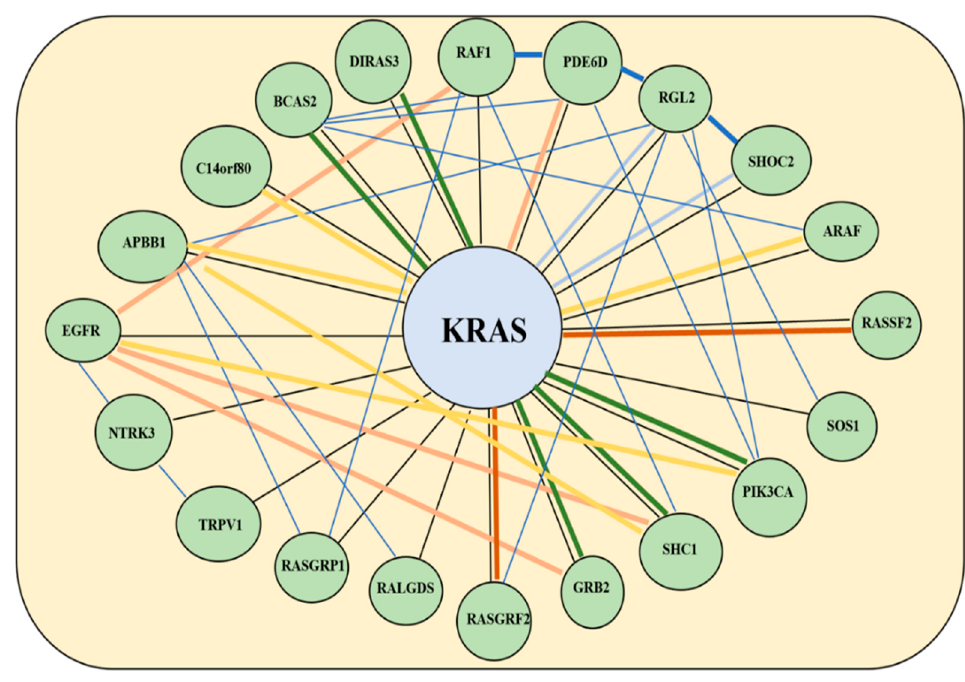
Figure 4. Gene co-expression network for KRAS as depicted using data from the Gene Expression Omnibus on the GeneMania platform. The differing thickness in lines relates to the strength of co- expression (thicker lines show stronger co-expression). Yellow lines denote physical interactions, blue lines denote co-expression, orange lines predict co-expression, blue lines co-localization, burgundy genetic interactions and black denotes similar pathways.